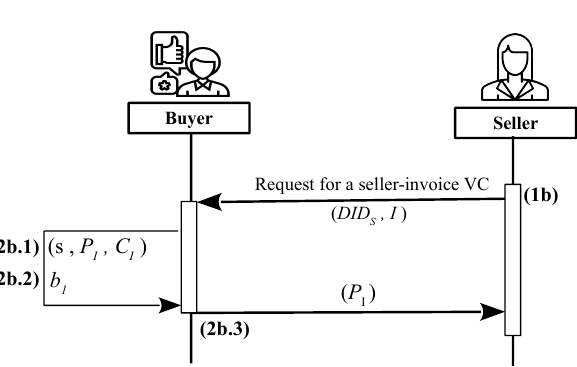
Figure 3. Registration of an invoice for a seller (seller-invoice